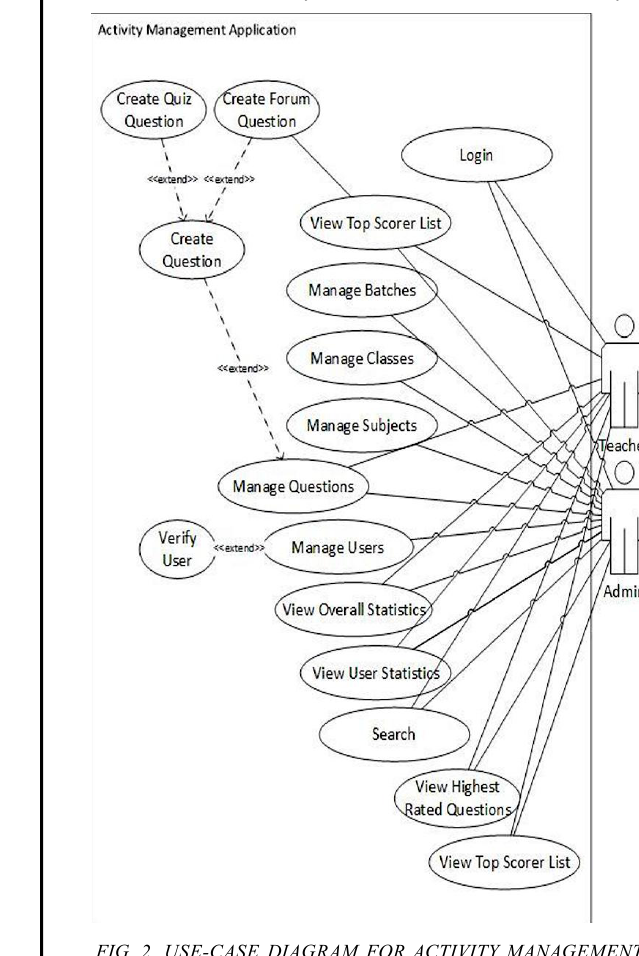
FIG. 2. USE-CASE DIAGRAM FOR ACTIVITY MANAGEMENT APPLICATION